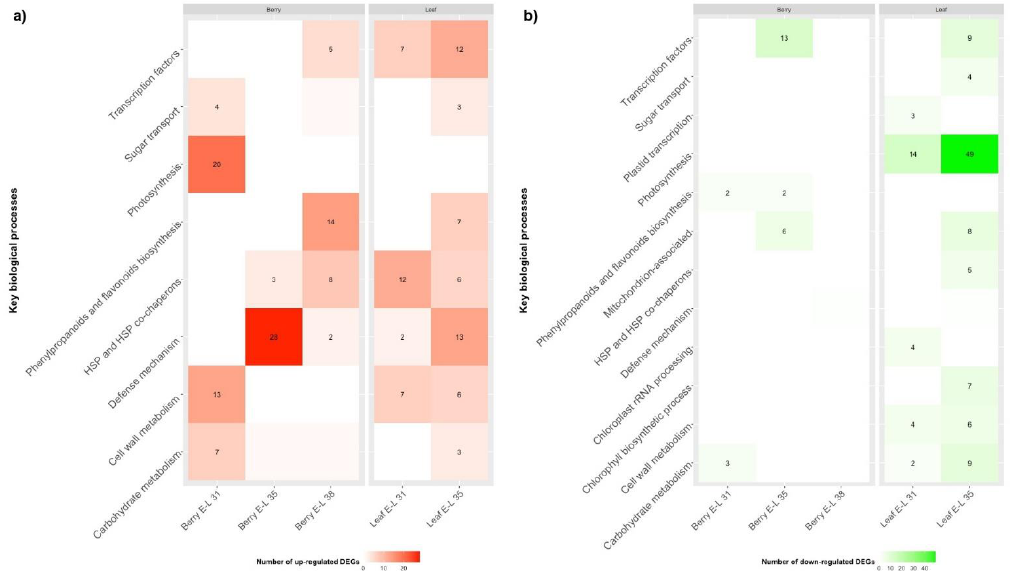
Figure 2. Heatmap of key biological processes up-regulated ( a ) or down-regulated ( b ) in GLRaV-3- infected leaf and berry at E-L 31, 35, and 38 developmental stages. Red colour indicates biological process being up-regulated, green colour indicates down-regulation. Color intensities correlate with the number of DEGs identified in each biological process. Biological processes (square spaces) with DEG number equal or smaller than 1 were not numbered. The complete list of enriched biological processes ( p < 0.05) can be accessed in Supplementary Table